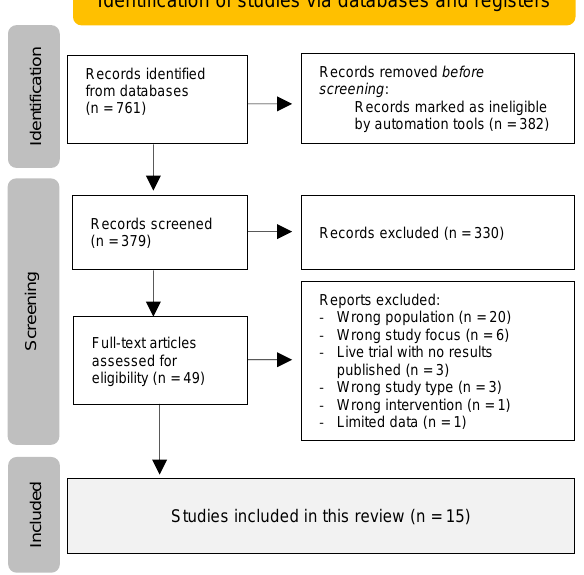
Figure 1: Study selection